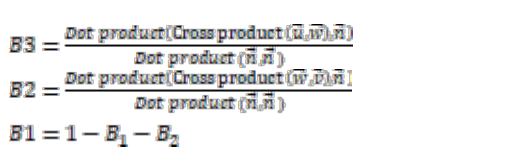
Figure 6. Irregular recursive triangulation